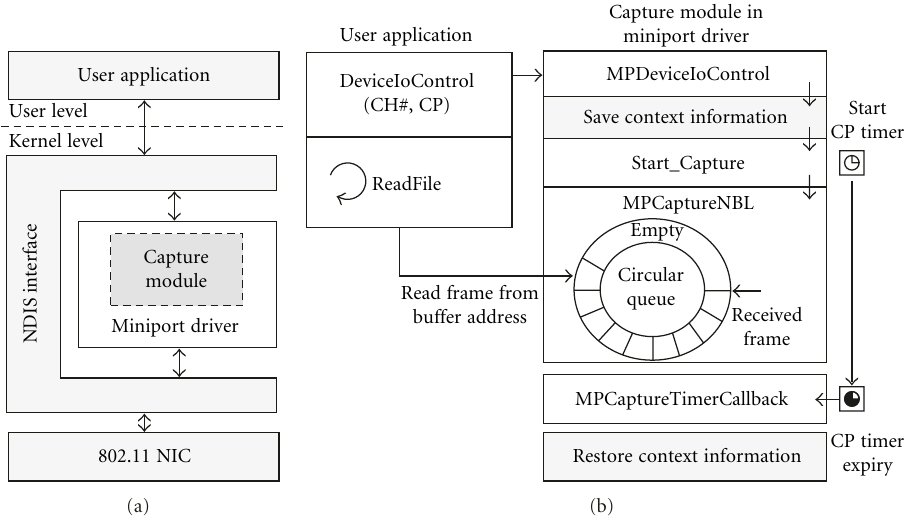
Figure 3: (a) Overall architecture of testbed implementation. (b) Work flows between user application and the capture module in the miniport